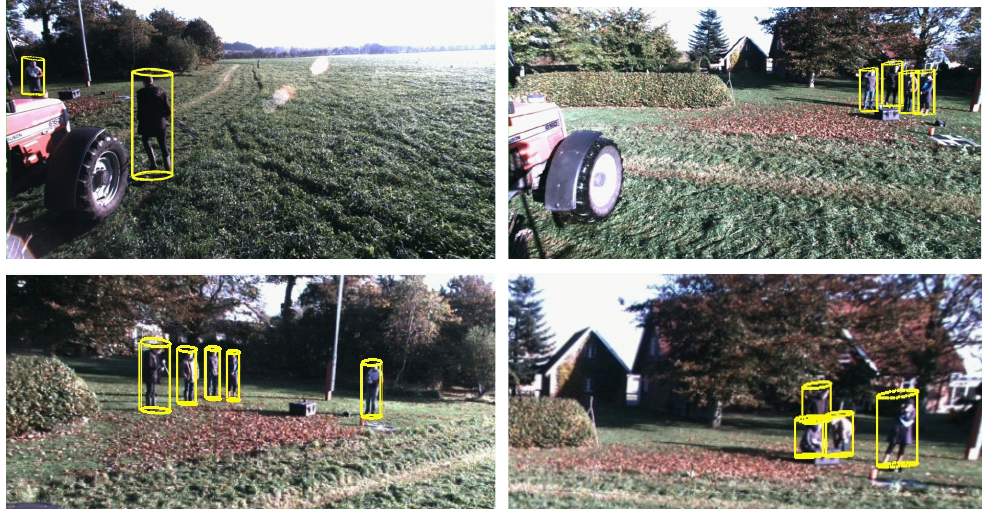
Figure 6. 3D pedestrian labels and annotated image